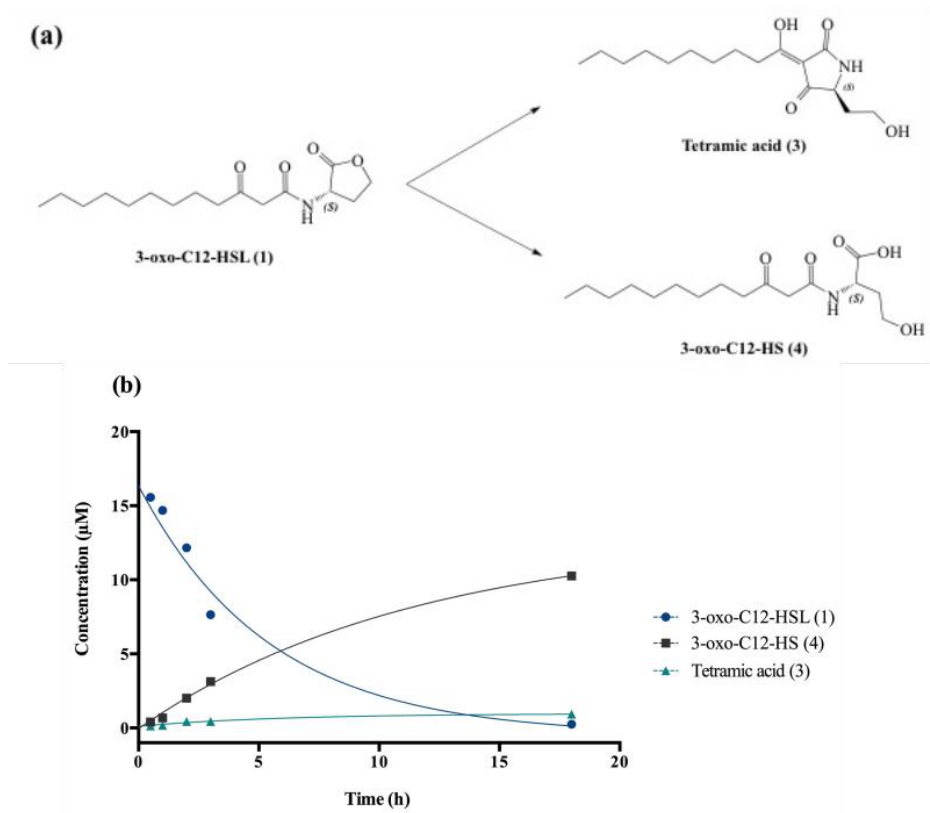
Figure 2. Degradation of 3-oxo-C12-HSL: ( a ) Degradation scheme into by-products (3) and (4). ( b ) Kinetics of decay of (1) in cell-free aqueous medium and apparition of tetramic acid (3) and 3-oxo- C12-HS (4).